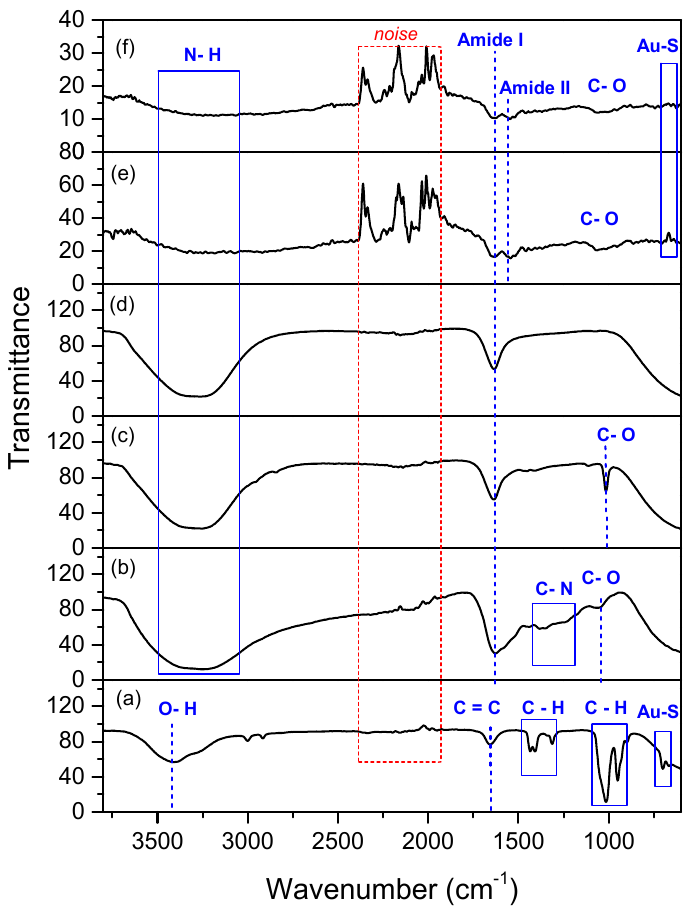
Figure 2. FTIR spectra of ( a ) DSU; ( b ) NH 2 rGO; ( c ) PAMAM; ( d ) IgM; ( e ) Au/DSU/NH 2 rGO-PAMAM/IgM sensor film; ( f ) Au/DSU/NH 2 rGO-PAMAM/IgM sensor film exposed to DENV-2 E- proteins.